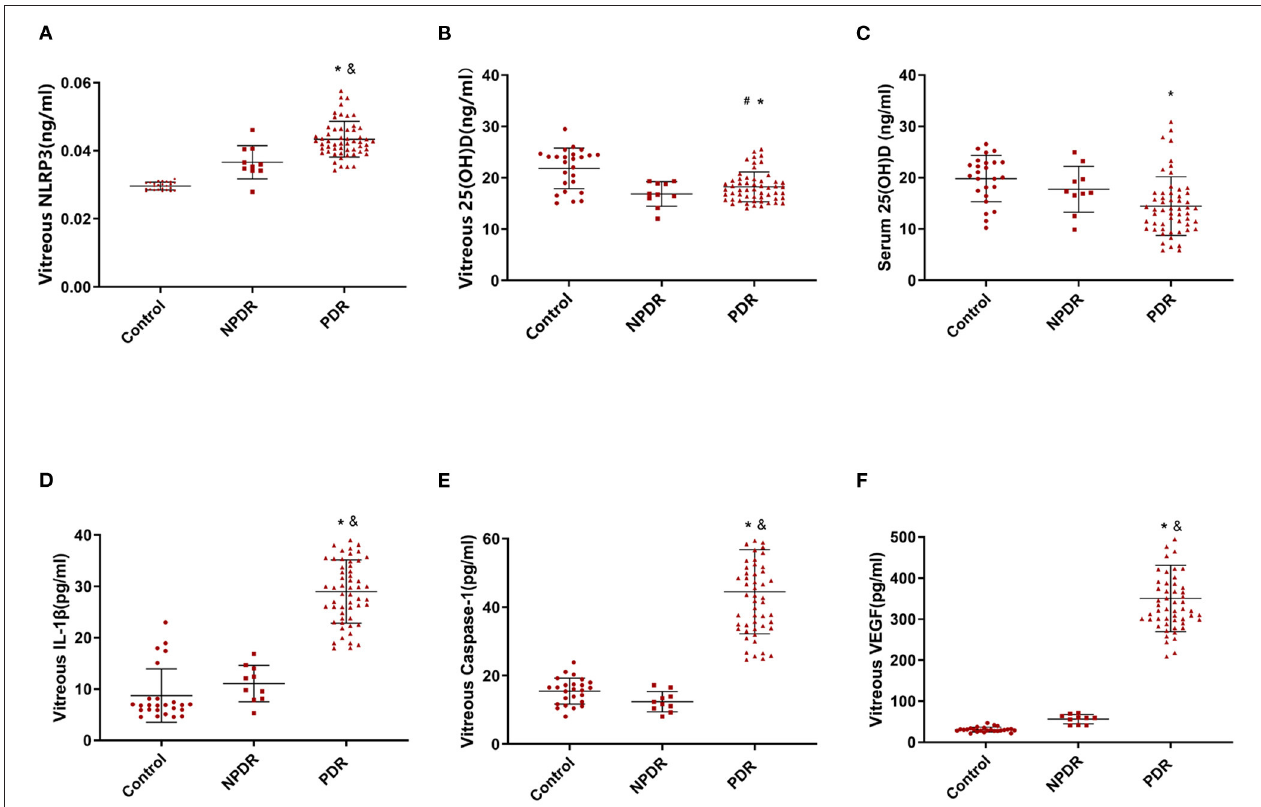
FIGURE 1 | The levels of NLRP3 and the concentrations of serum and vitreous 25 (OH) D in three groups. (A) Vitreous NLRP3 levels in PDR, NPDR, and control groups. (B) Vitreous 25 (OH) D concentrations in PDR, NPDR, and control groups. (C) Serum 25 (OH) D concentrations in PDR, NPDR, and control groups. (D) Vitreous IL-1 β levels in PDR, NPDR, and control groups. (E) Vitreous caspase-1 levels in PDR, NPDR, and control groups. (F) Vitreous VEGF levels in PDR, NPDR, and control groups. # P < 0.01, Control vs. NPDR; * P < 0.01, Control vs. PDR; & P < 0.01, NPDR vs.